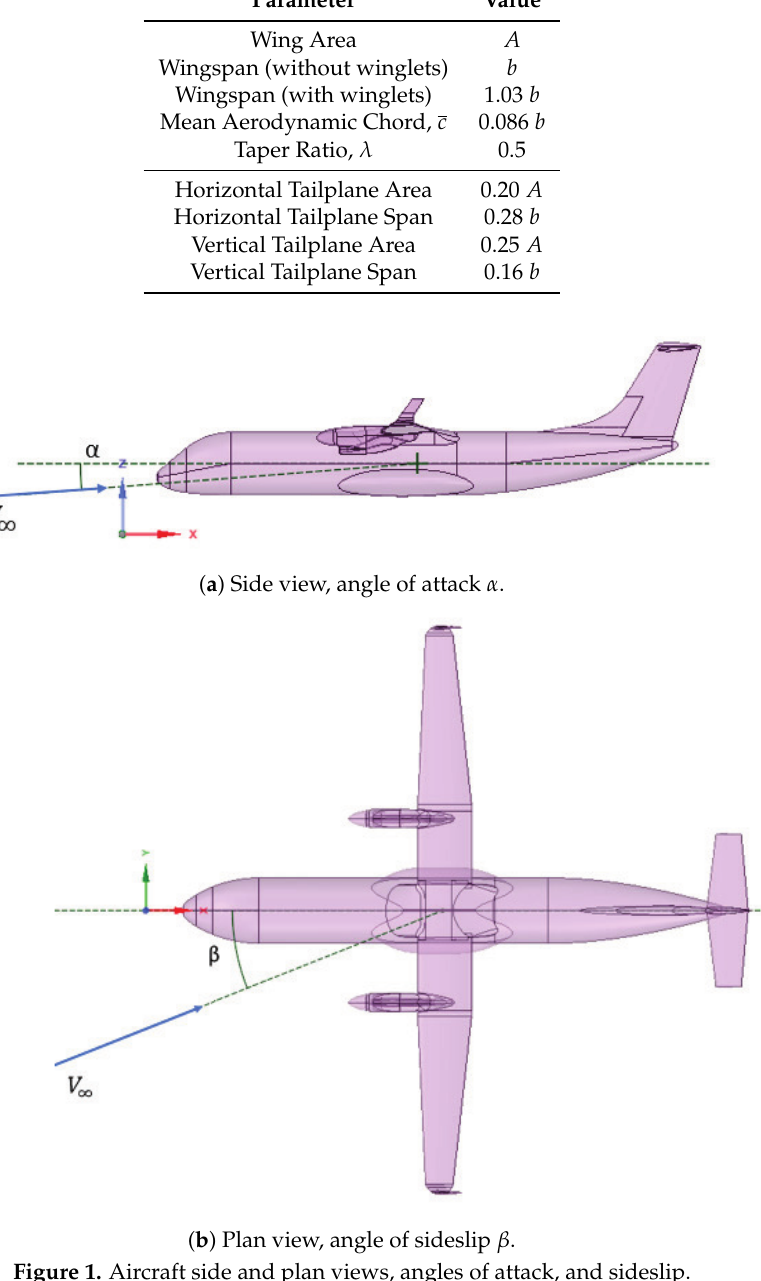
Figure 1. Aircraft side and plan views, angles of attack, and